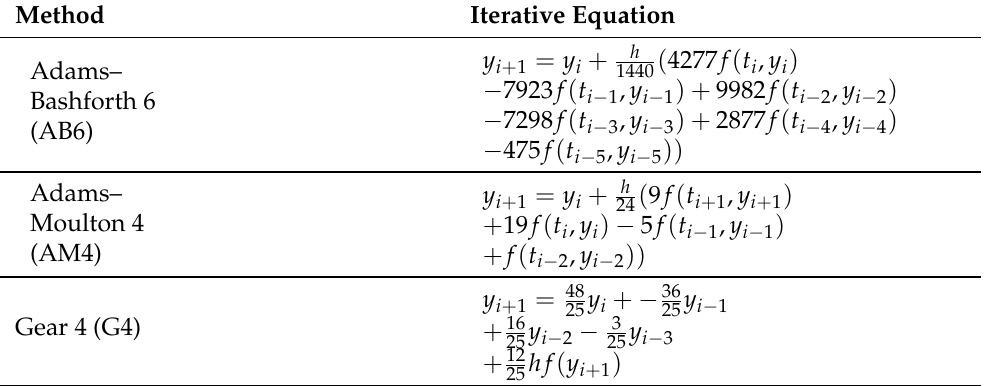
Table 3. Multi-step